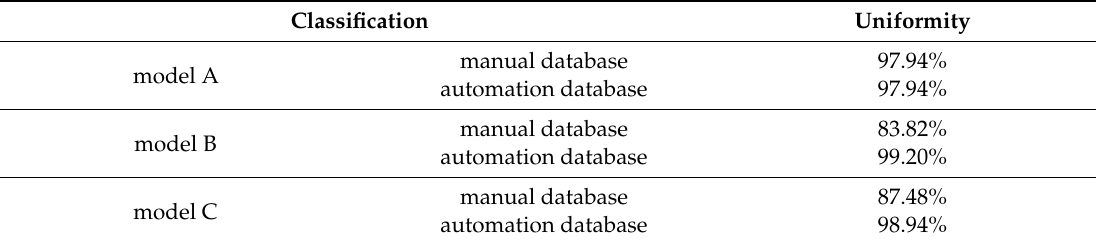
Table 6. Database